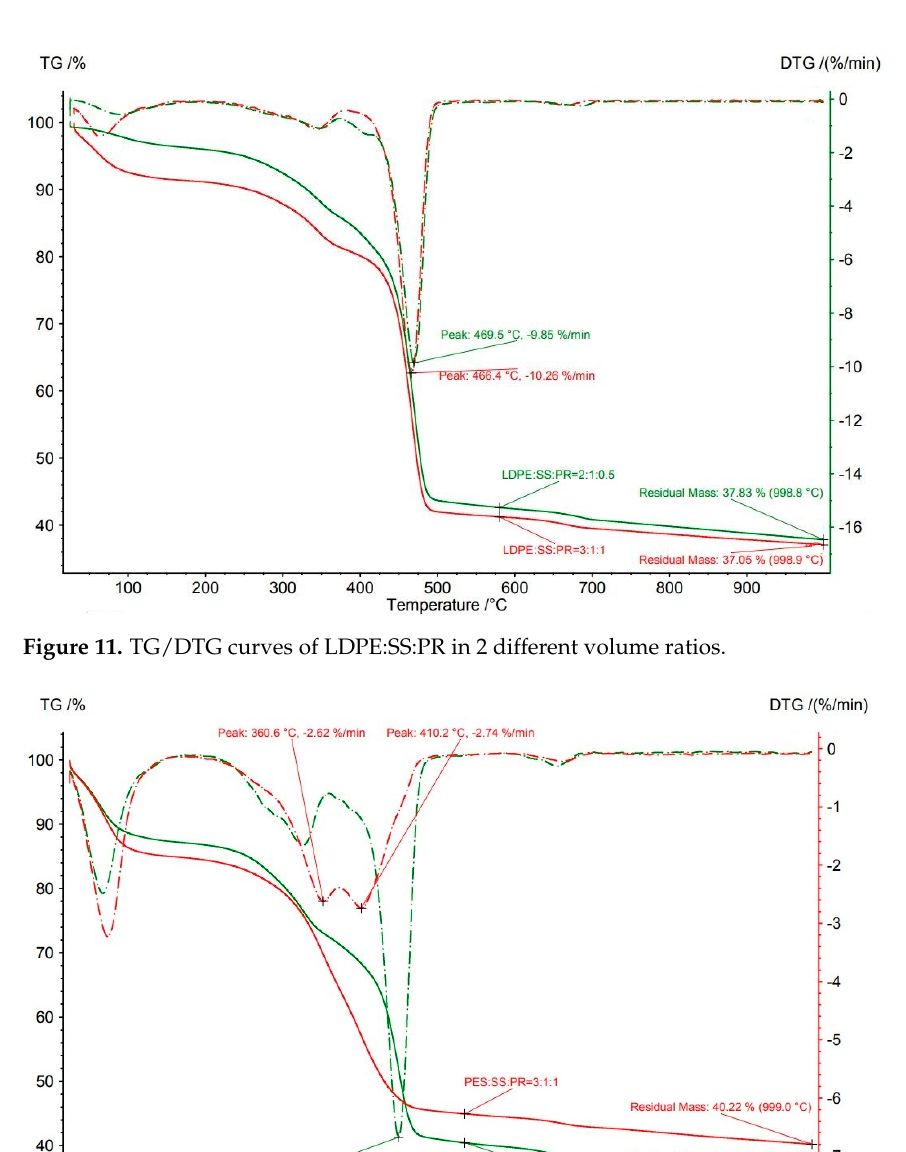
Figure 12. TG/DTG curves of PES:SS:PR and RDF:SS:PR in the same volume ratio. Table 2. TGA/DTG results of waste